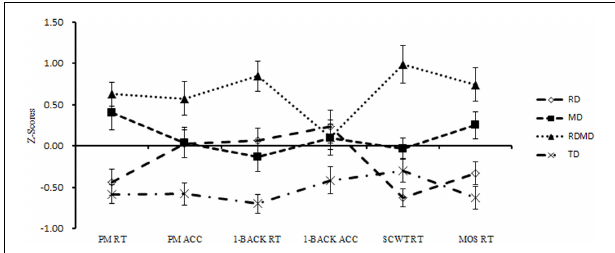
FIGURE 1 | Z -scores on executive function tasks and PM by LD subgroups. The Z -scores for acc-related tasks (PM and 1-back) are reversed. PM, prospective memory; 1-back, N-back task (updating); SCWT, Stroop color-word test (inhibition); MOS, more-odd task (shifting); ACC, accuracy; RT, response